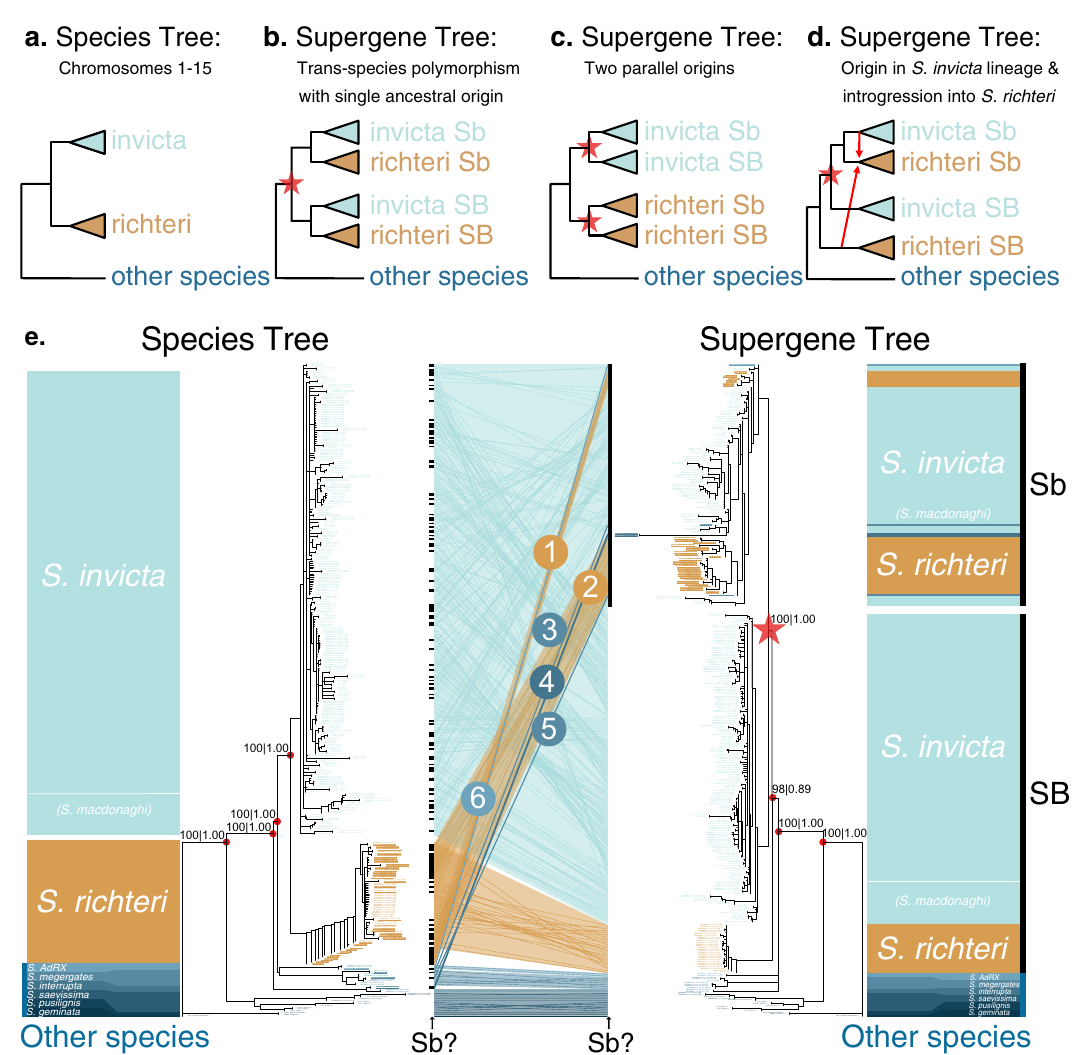
Fig. 1 Hypothetical and empirical species and supergene phylogenetic trees. a – d A simpli fi ed species tree ( a ), and hypothetical scenarios for the evolutionary history of the supergene ( b – d ). b SB and Sb supergene variants diverged (star) in the common ancestor of S. invicta and S. richteri; the supergene is thus a trans-species polymorphism. c Sb evolved twice from SB, representing independent origins (stars) after the separation of the two species. d Sb diverged in S. invicta and spread to S. richteri through introgression (arrows). e Empirical coalescent-based trees of 368 Solenopsis samples based on 1631 single-gene trees from chromosomes 1 – 15 (left; species tree) and 97 single-gene trees from the supergene region of chromosome 16 (right; supergene tree). Branches shorter than 0.05 were collapsed into polytomies. A tanglegram (middle) indicates the relative positions of each sample in both trees. Circled numbers highlight patterns consistent with introgression of Sb from S. invicta/macdonaghi into other species. On either side of the tanglegram black bars indicate where samples with the Sb genotype can be found in the two trees. Support values (ASTRAL bootstrap support | local posterior probability) are provided for key nodes of speciation and supergene